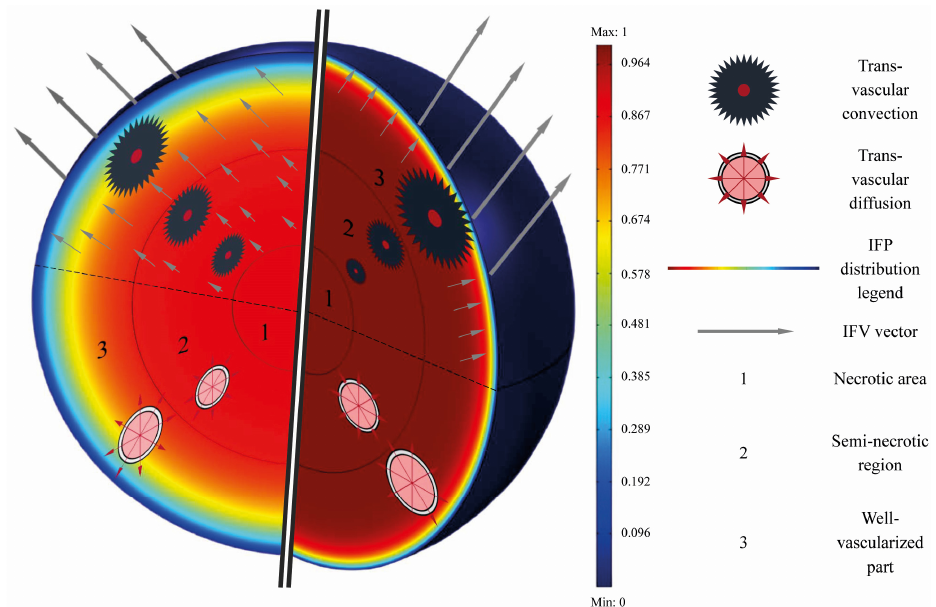
Figure 3. Cross-sectional schematic of a non-homogeneous solid tumor before and after the anti- angiogenic therapy.